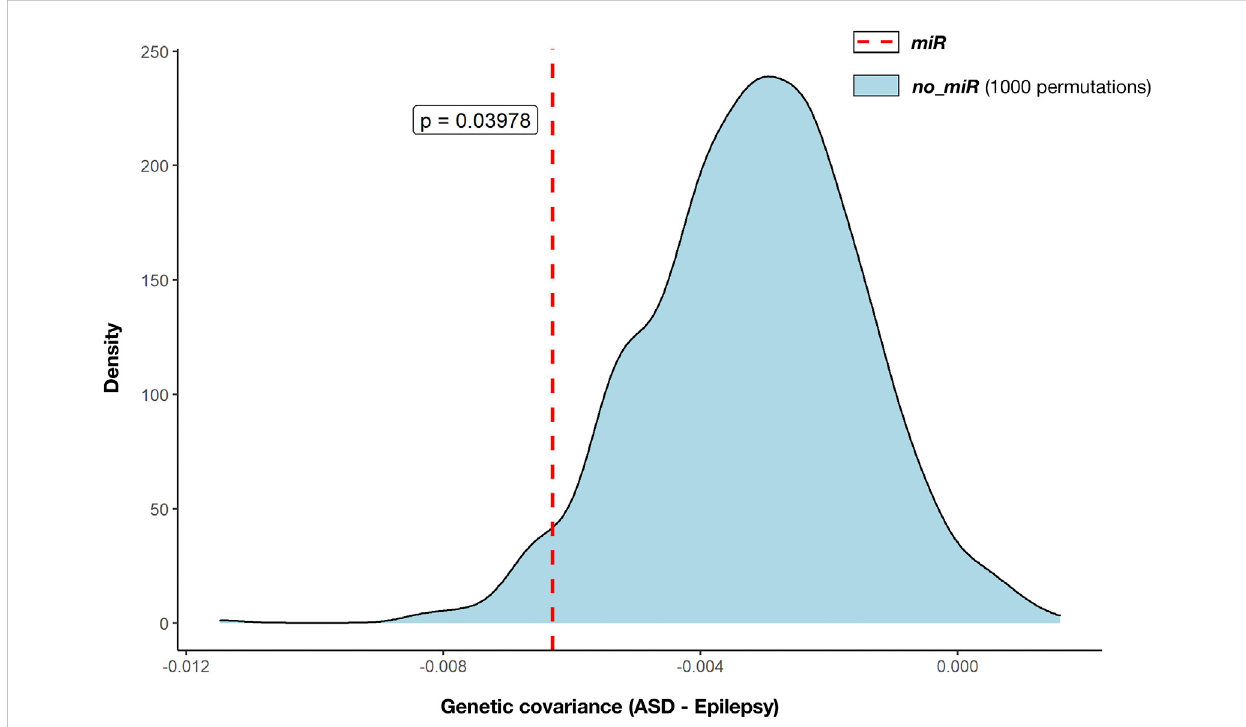
FIGURE 2 Genetic covariance between autism (ASD) and epilepsy across miRNA target gene annotations. Partial genetic covariances were calculated with GNOVA (Table 2). Estimated genetic covariance between ASD and epilepsy across genes targeted by the selected 14 miRNAs (miR: 4,581 genes, red dashed line) was compared against 1,000 genetic covariances across genes not targeted by the selected 14 miRNAs (no_miR, blue density distribution) that were estimated after 1,000 random selections of the same number of genes (4,581 genes). Statistical comparison between genetic covariance across miRNA target genes and the distribution of genetic covariances across the remaining genes was performed by one-sided t -test. The derived p -value is displayed ( p =